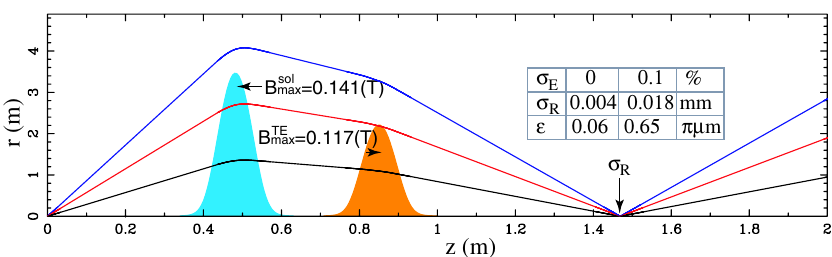
FIG. 10. (Color) Probe particle trajectories of the beam in the combination of the static solenoid and rf lens. (cid:6) just after the source, before the lens. != 2 (cid:5) (cid:4) 2 : 47 GHz